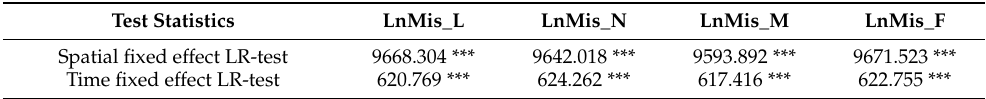
Table 5. Spatial and time fixed effects test